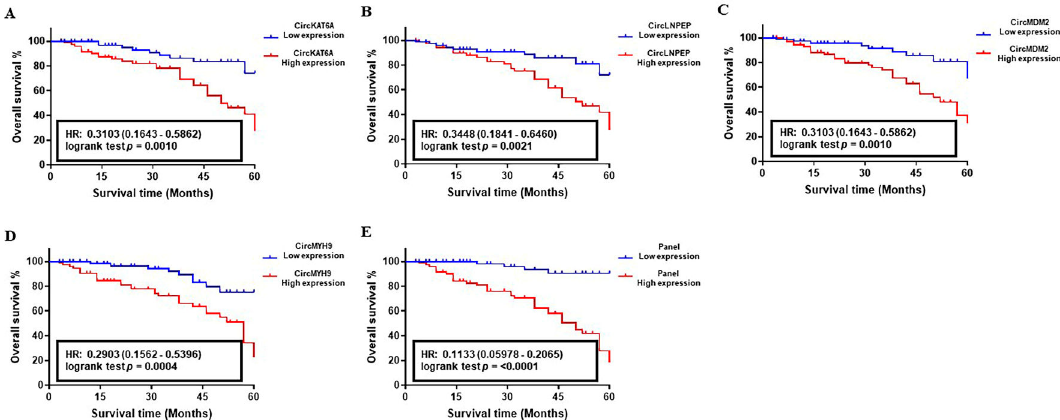
Figure 7. Correlation between the abnormal expression of candidate circRNAs and overall sur- vival (OS) of CLL in validation set II ( n = 251). ( A – D ) Survival impact of CircKAT6A, CircLNPEP, CircMDM2, and CircMYH9 as individual biomarkers, and ( E ) in the form of a panel in CLL. A Kaplan- Meier analysis indicated a reverse correlation between the high level of circRNAs individually and combined, and the worse survival of CLL patients in the validation set